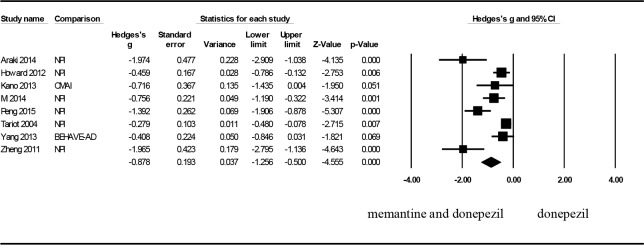
Forest plots to compare the combination therapy with the monotherapy: BPSD.